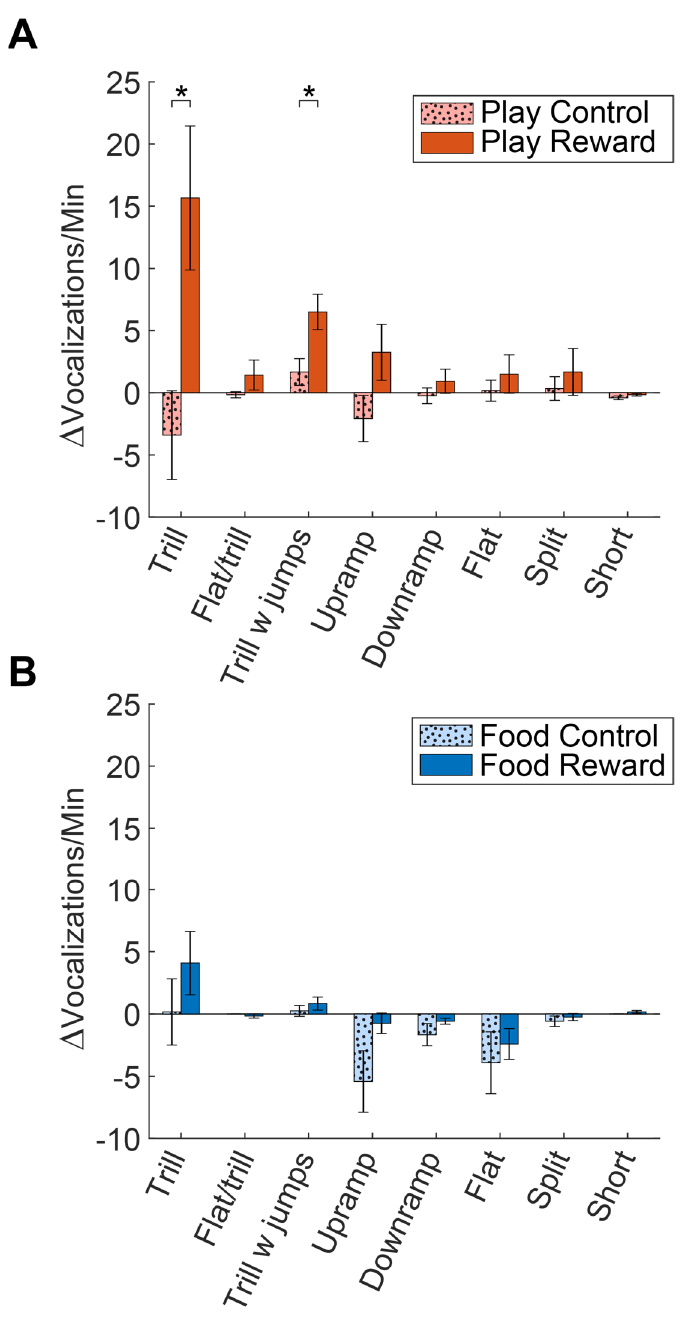
Figure 3. Comparison of the increase/decrease in call rates from day 1 to day 7 for each category of commonly produced calls. ( A ) Comparison of the change in call rates for Play Reward and Play Control groups. Asterisks denote comparisons that were statistically significant ( p < 0.05). ( B ) Comparison of the change in call rates for Food Reward and Food Control